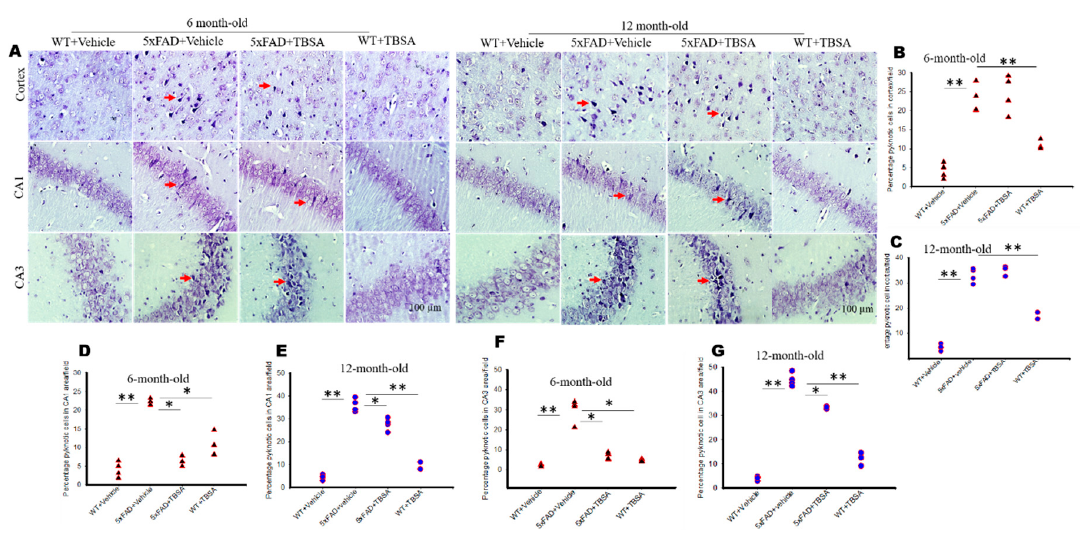
Figure 4. Treatments of trans-beta-styryl-boronic acid (TBSA) compound decreased pyknotic, tangle-like cells in the cortex and hippocampus of 5xFAD mice. Six and twelve-month-old 5xFAD and age-matched control mice were treated with TBSA (0.5 mg/kg) or vehicle for 2 months at which time they were euthanized, and their brains were perfused with 4% paraformaldehyde. The brains were then embedded in paraffin and cut on a rotary microtome into 5-µm coronal sections which were stained with 0.1% cresyl violet. Images were taken through a compound light microscope using a 100x objective (total magnification 1000x). There was a significant increase in the percentage of pyknotic cells in the cortex ( A – C ), in CA1 ( A , D , E ) and CA3 ( A , F , G ) areas of hippocampus of the vehicle-treated 5xFAD mice, but these increases were mitigated by TBSA treatments in the CA1 and CA3 hippocampus regions. Values are expressed as means ± SEM; scale bar = 100 µm and is applicable to all images. Sale bar = 100 µm and is applicable to all images. * p < 0.05 and ** p < 0.01 in comparison to WT + Vehicle, 5xFAD + TBSA and WT + TBSA.